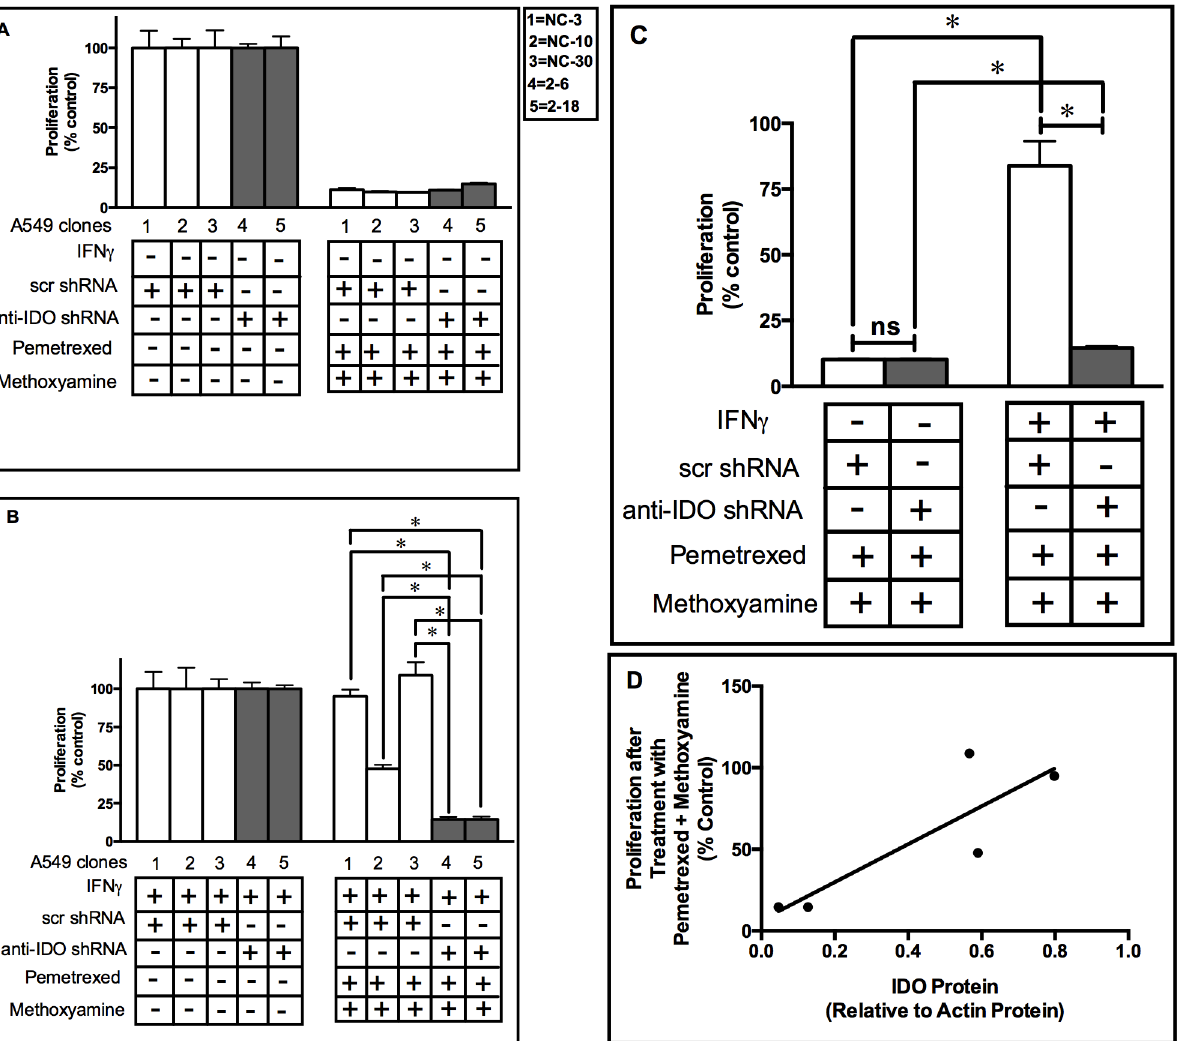
Fig 4. A549 clone sensitivity to combined pemetrexed and methoxyamine treatment before and after IDO induction. Proliferation of each of 5 individual A549 cell clonal populations before (Panel A) and after (Panel B) IDO induction with IFN γ . A549 clonal populations were cultured with or without IFN γ (25 ng/ml) for 48 h. Cultured medium was then replaced with fresh growth medium containing pemetrexed (30 nM) and methoxyamine (MX) (3 mM). Tumor cells were then allowed to proliferate for 72 h, then enumerated. White bars : A549 clones transfected with scrambled, non-targeting control shRNA. Gray bars : A549 cells transfected with anti-IDO shRNA. Each bar represents the mean of 3 values ( n = 3) ± SD. * Significant difference, Student's t -test, p < 0.05. Results are normalized to control cells not treated with pemetrexed and methoxyamine, without (panel A) or with (panel B) IFN γ treatment. Panel C : Induction of IDO in A549 clonal cell induces resistance to combined pemetrexed (30 nM) and MX (3 mM) treatment. Results were obtained from 3 independent clonal cell populations with scrambled control shRNA or anti-IDO shRNA, and each bar represents a mean of 9 (white bars) or 6 (black bars) values ± SEM ( * p < 0.05). Panel D : relationship between IDO protein (relative to actin) and clonal population resistance to combined pemetrexed and MX treatment proliferation relative to untreated control cells). The R 2 value of 0.72 represents a moderate positive